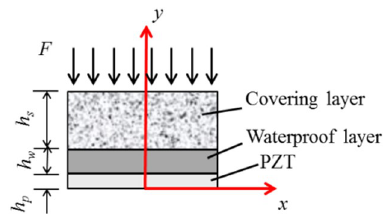
Figure 3. A half-model of the embeddable lead zirconate titanate (PZT) transducer [26].